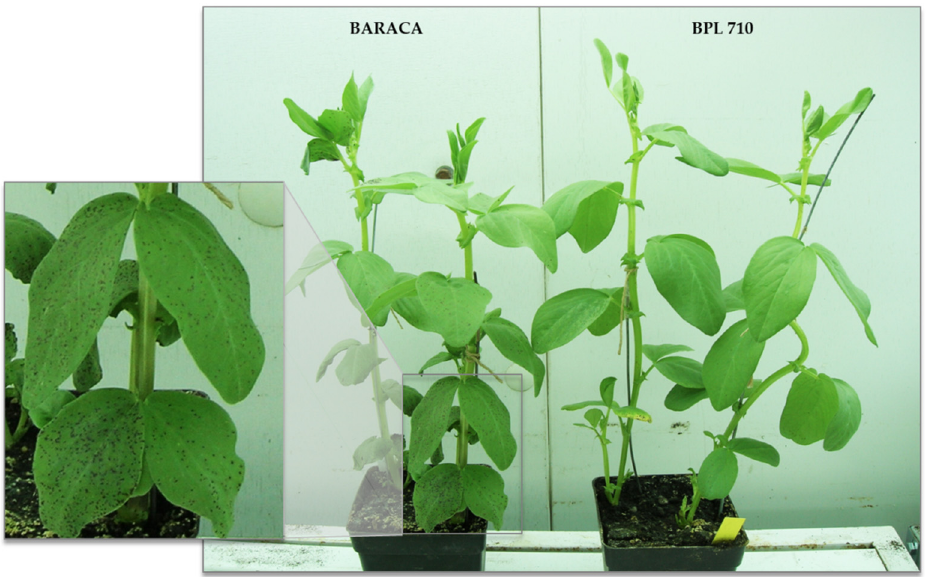
Figure 1. Contrasting response to B. fabae infection of three-week-old faba bean plants of Baraca (susceptible genotype) and BPL710 (resistant genotype) 12 h after inoculation.